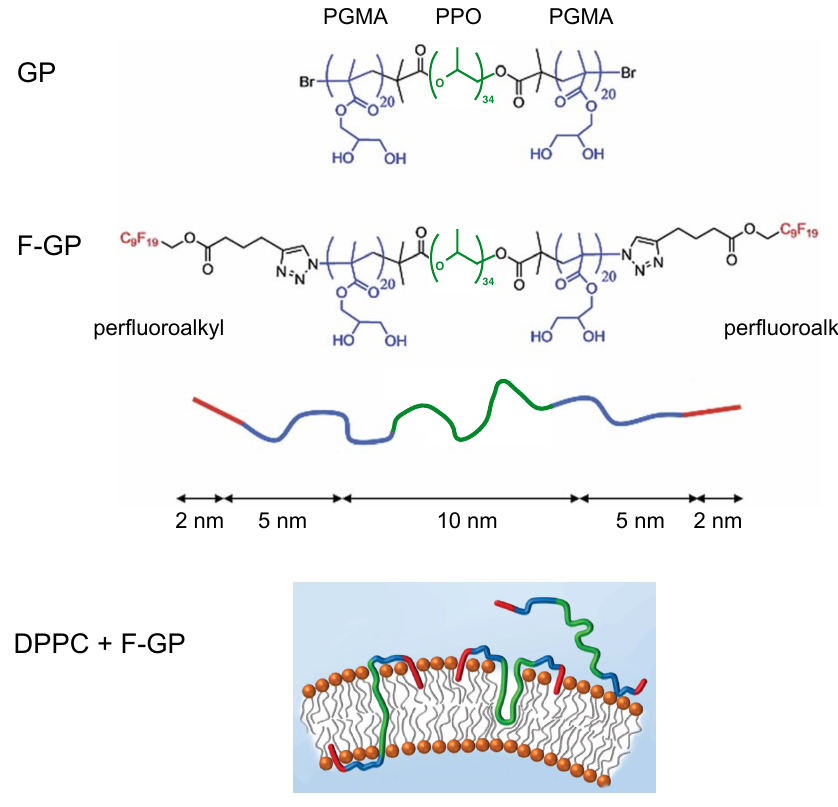
Figure 1. Molecular structure of the triblock copolymer PGMA 20 -PPO 34 -PGMA 20 (GP) and the pentablock copolymer F 9 -PGMA 20 -PPO 34 -PGMA 20 -F 9 (F-GP). The approximate contour length of the hydrophobic (green), hydrophilic (blue) and fluorophilic (red) block is given. The different possibilities of the pentablock copolymer F-GP to interact with the lipid bilayer are shown schematically. Figure adapted from ref. [16] published by the Royal Society of